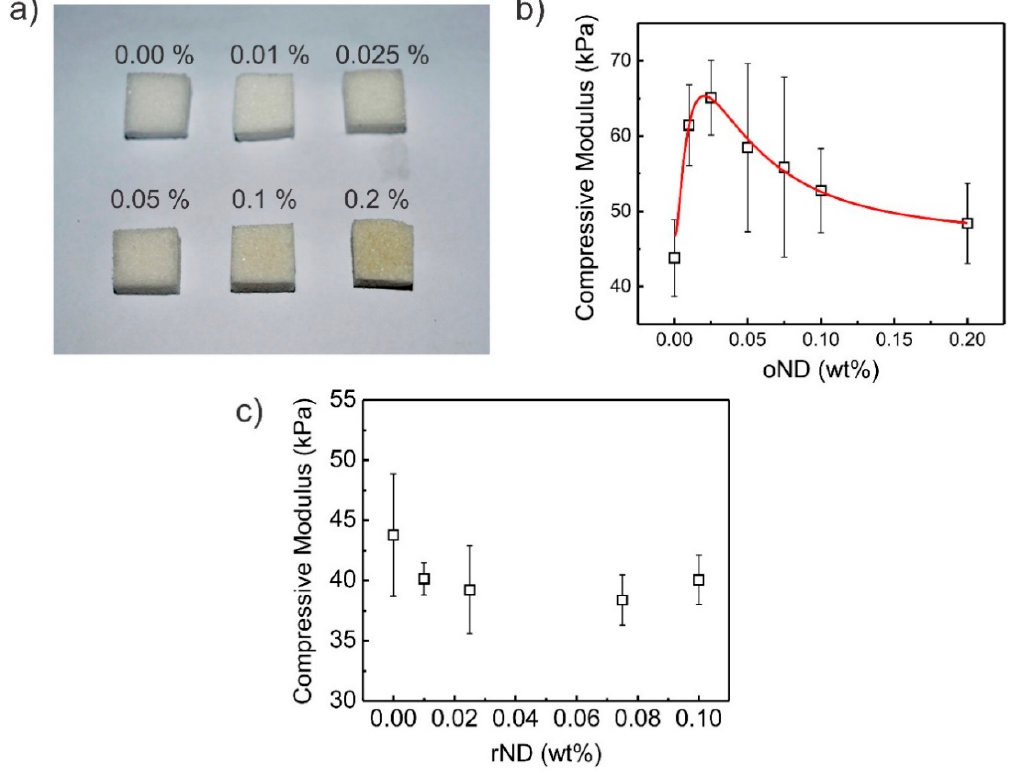
Figure 3. ( a ) Optical images of PDMS / oND composite sponges. Compression moduli of PDMS / ND composite sponges with increasing wt % of blended ND particles. ( b ) Oxidized ND particles and ( c) reduced ND particles were used.